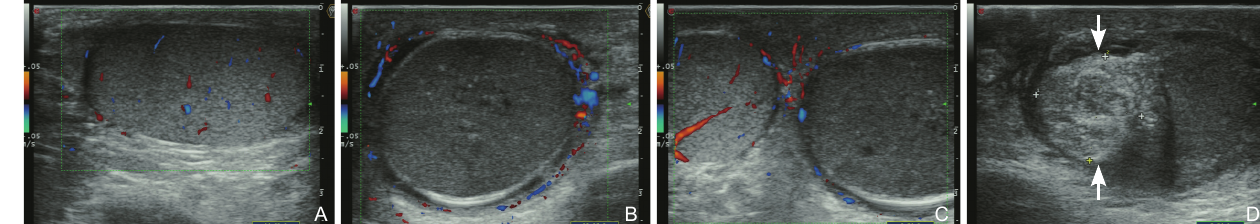
A B C D Figure 2 A fifteen-year-old boy had left-sided testicular torsion which was confirmed by surgery (orchiectomy). Histopathologic results revealed testicular necrotic infarction. (A) CDU imaging in the longitudinal plane shows normal vascularization of the right testis; (B) CDU imaging in the longitudinal plane shows ABF in the left testis. The image also shows hypoechogenicity and heterogeneous echogenicity in the left testis; (C) CDU imaging in the dual transverse plane shows ABF in the left testis (right) and normal vascularization of the right testis (left). The image also shows hypoechogenicity and heterogeneous echogenicity in the left testis (right); (D) grayscale ultrasound imaging in the longitudinal plane shows whirlpool sign above the left testis (arrows).